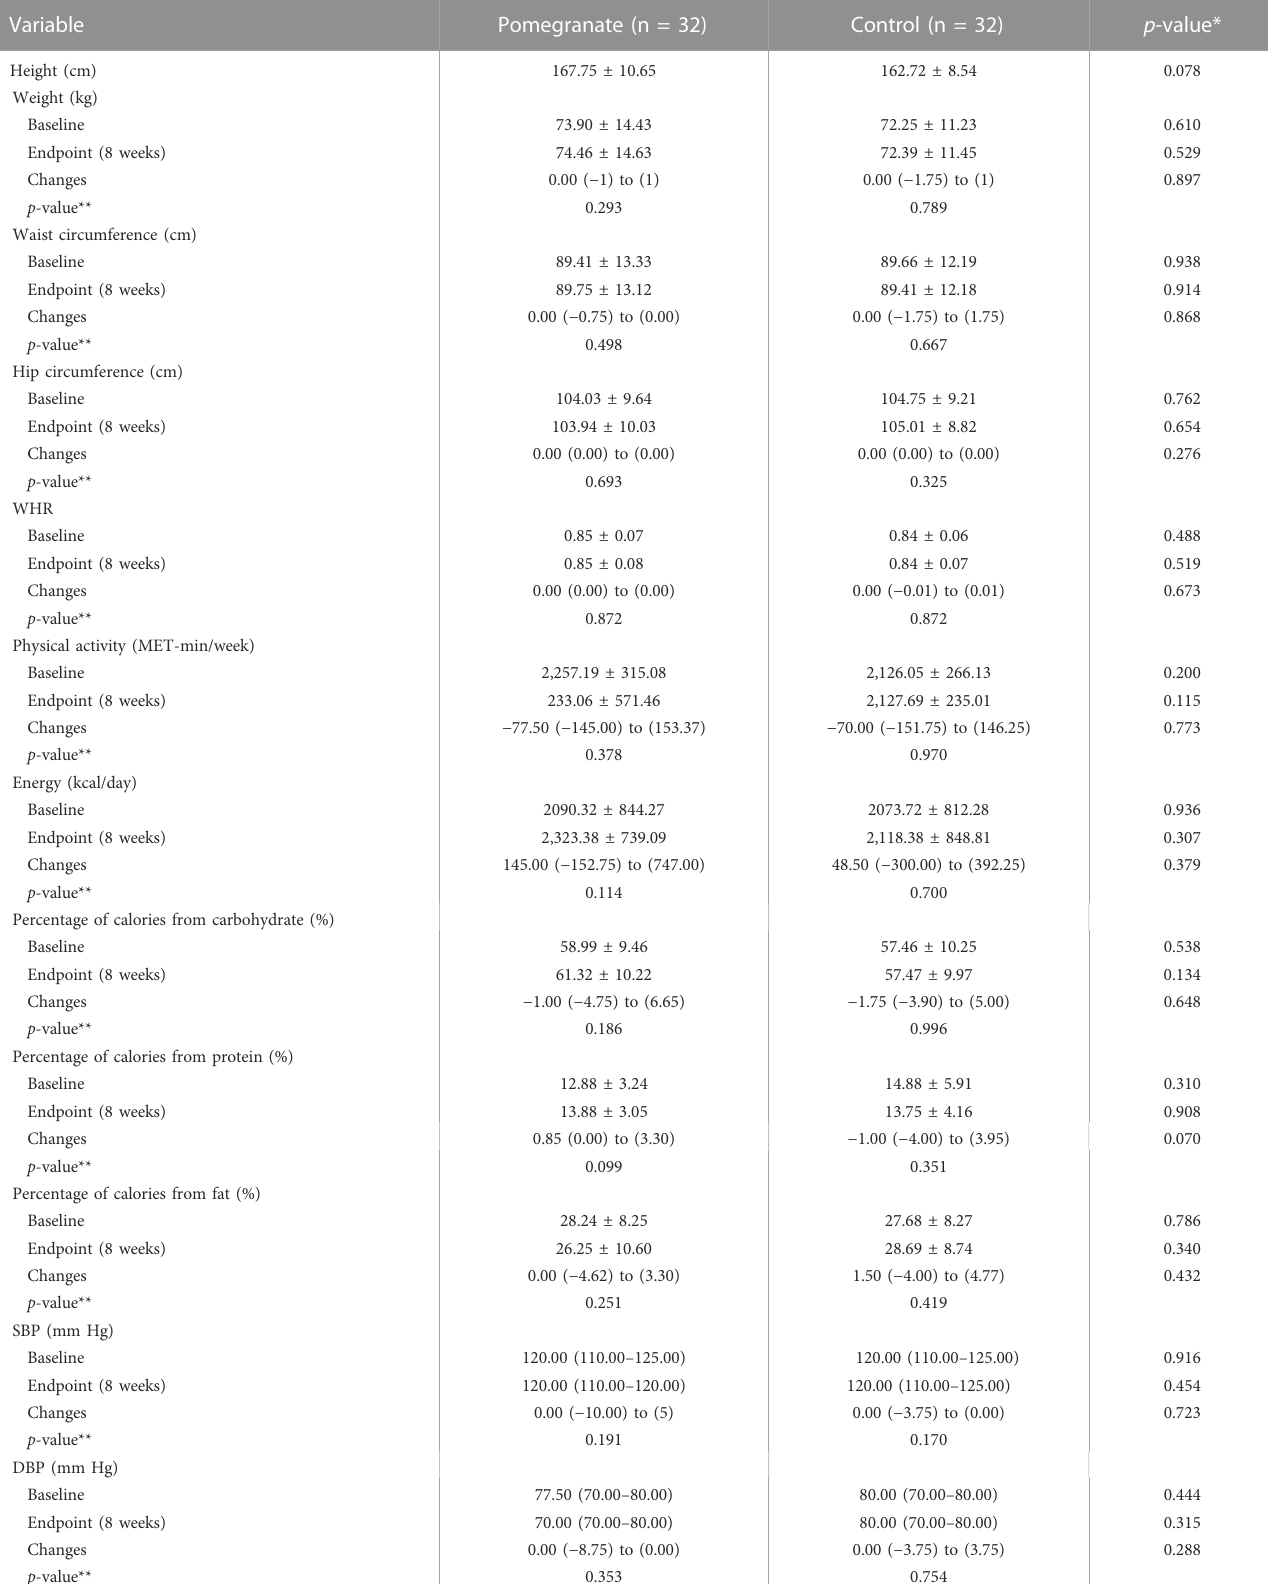
TABLE 2 Comparing anthropometric indices, physical activity, dietary intake, and blood pressure in the intervention and control groups.